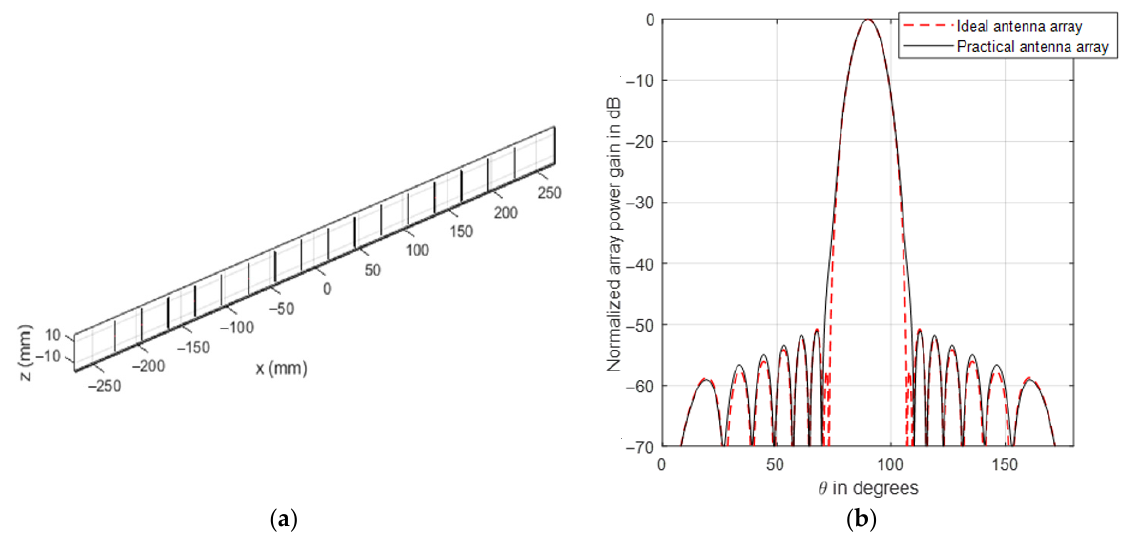
Figure 10. ( a ) Practical configuration of linear array of 16 half-wavelength dipoles operating at 5 GHz frequency; ( b ) array performance for both the ideal and practical implementation of the adaptive SSR weights to achieve − 50 dB SLL.